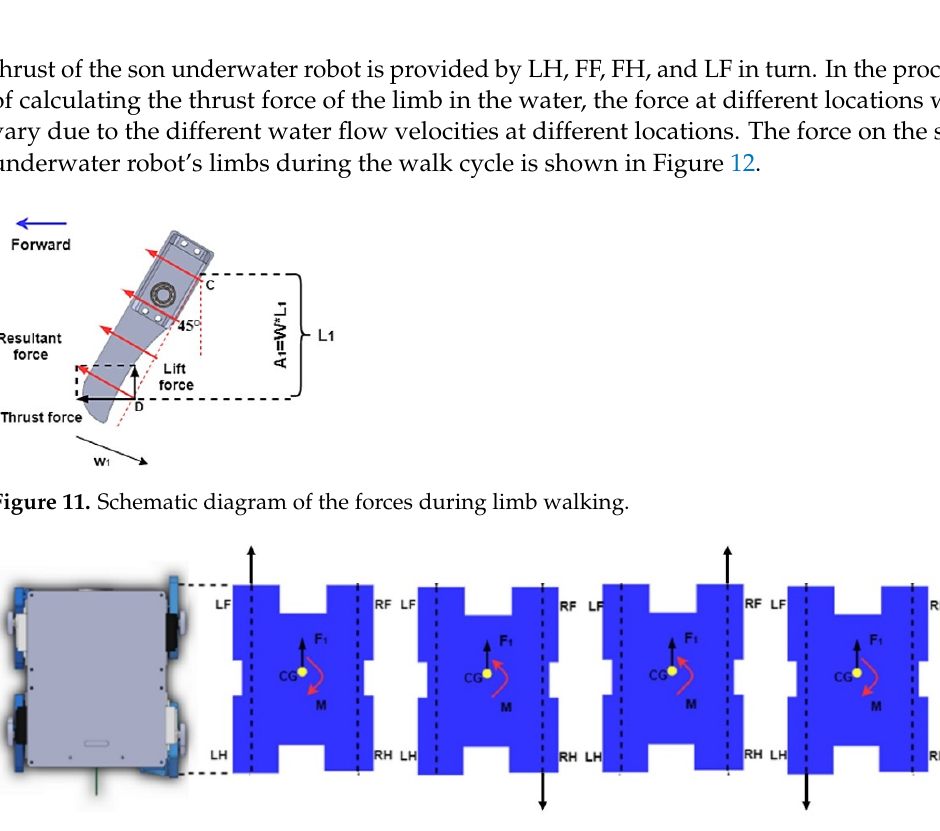
Figure 12. Limb forces in a walking cycle.